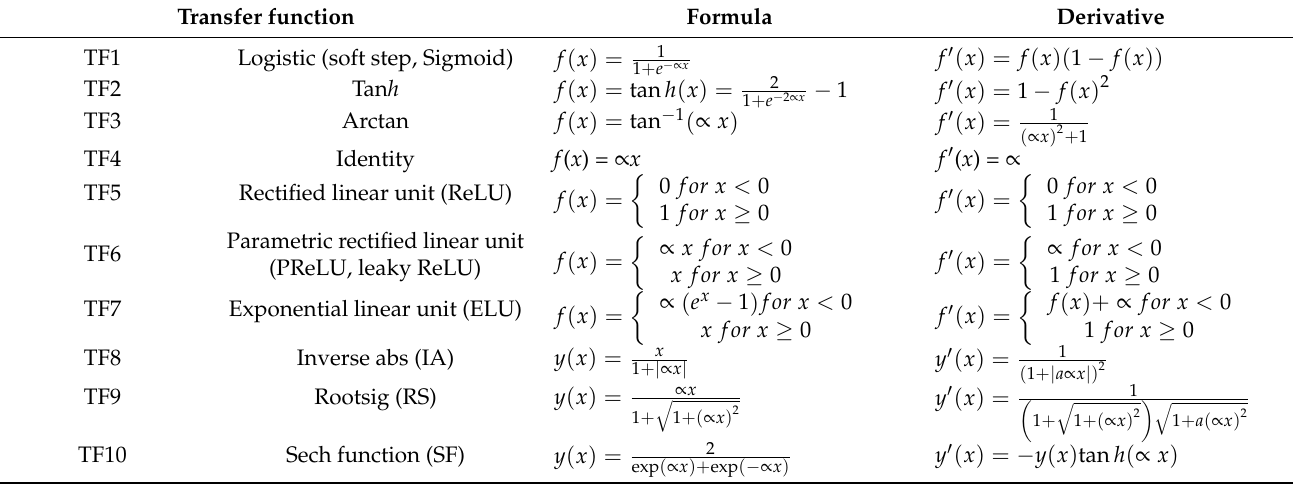
Table 2. Transform functions commonly used (Wu et al., 2021, Maca et al., 2014) [18,38]. Transfer function Formula